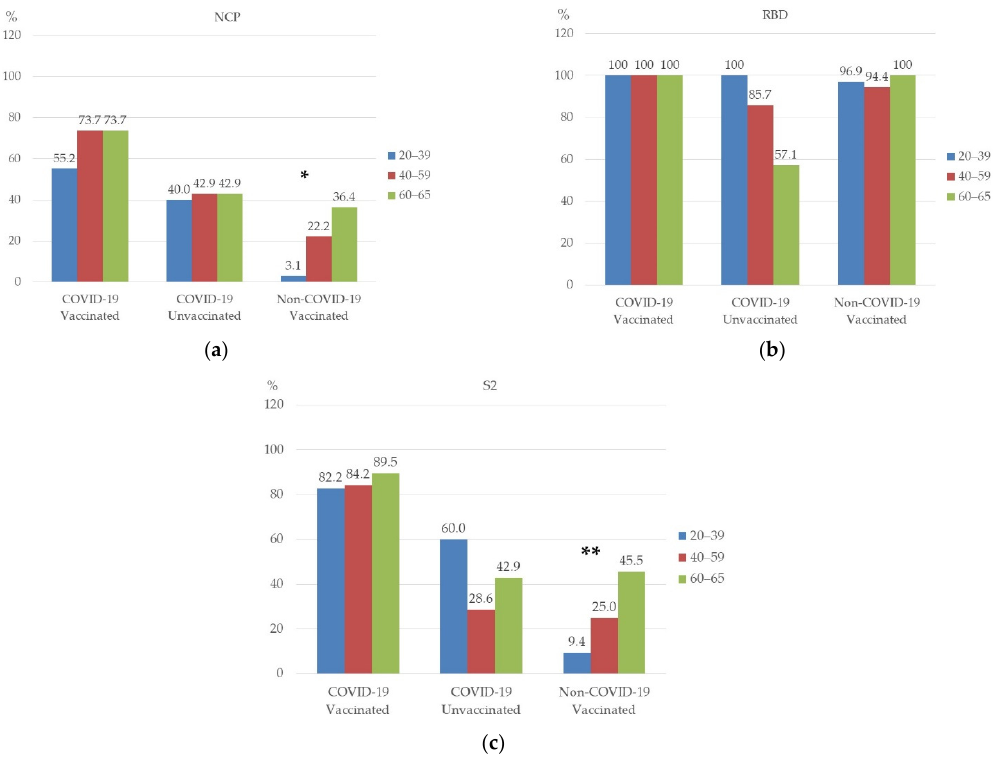
Figure 3. Prevalence of NCP ( a ), RBD ( b ), and S2 ( c ) antibody by age. * p = 0.002; ** p = 0.005.